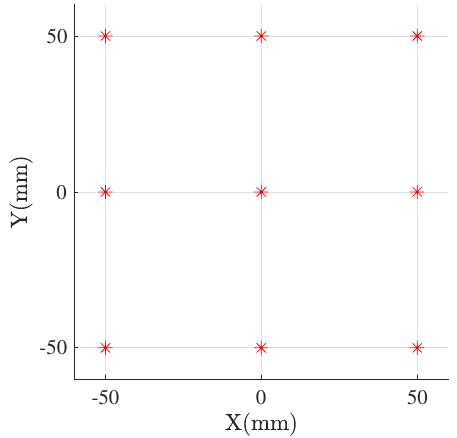
Figure 3. Position of the ultrasound